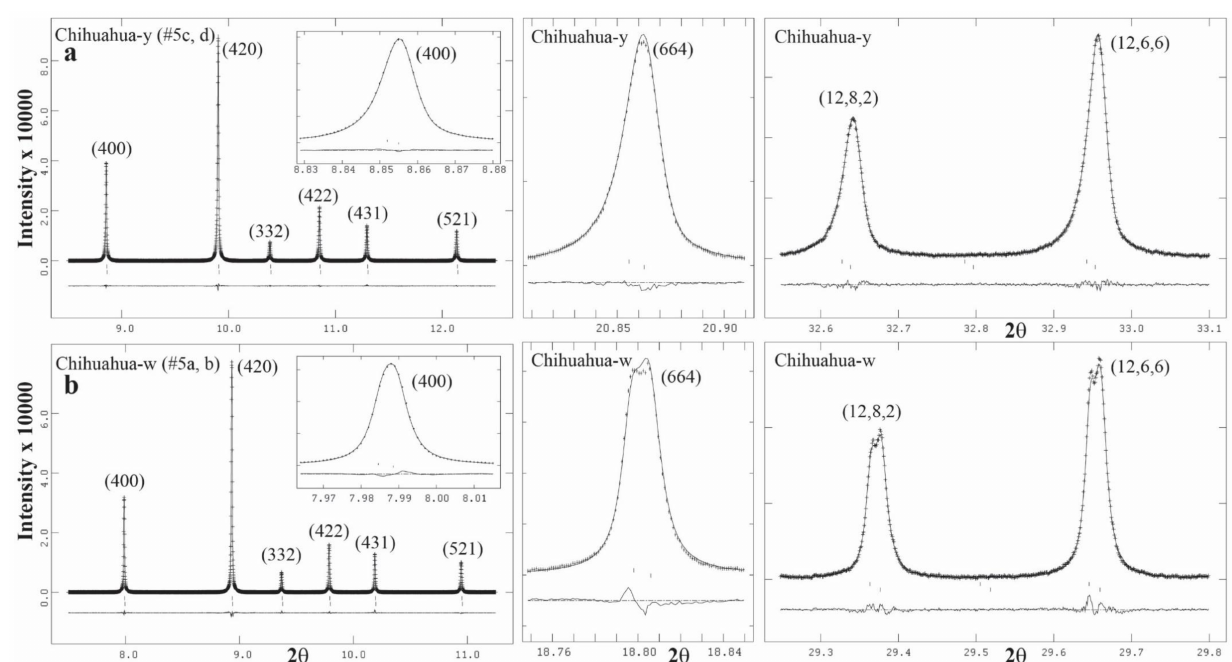
Figure 17. The same reflections are displayed for the two-phase samples from ( a ) Chihuahua-y, Mexico (sample-5) and ( b ) Chihuahua-w, Mexico (sample-5). Each reflection peak in ( a ) is asymmetric because of two different cubic phases, whereas those in ( b ) show clear splitting from the two phases.